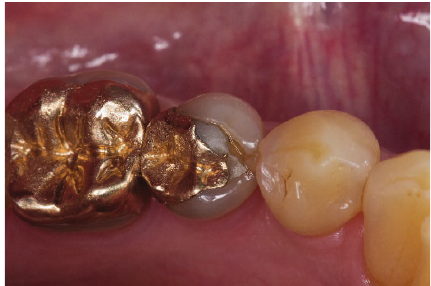
Figure 1: Insufficient cast gold inlay on a lower second premolar.